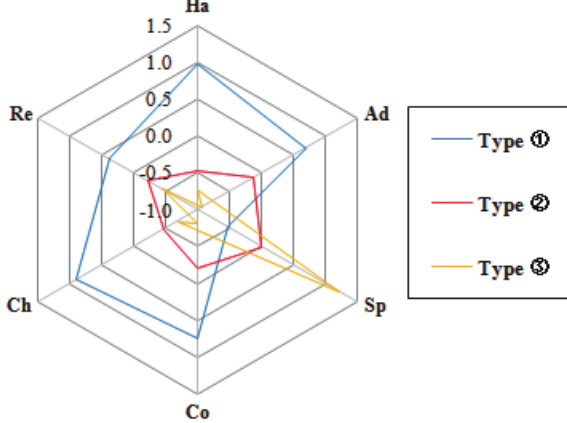
FIGURE 3 - Radar chart of the physical properties of wet masses for three types of